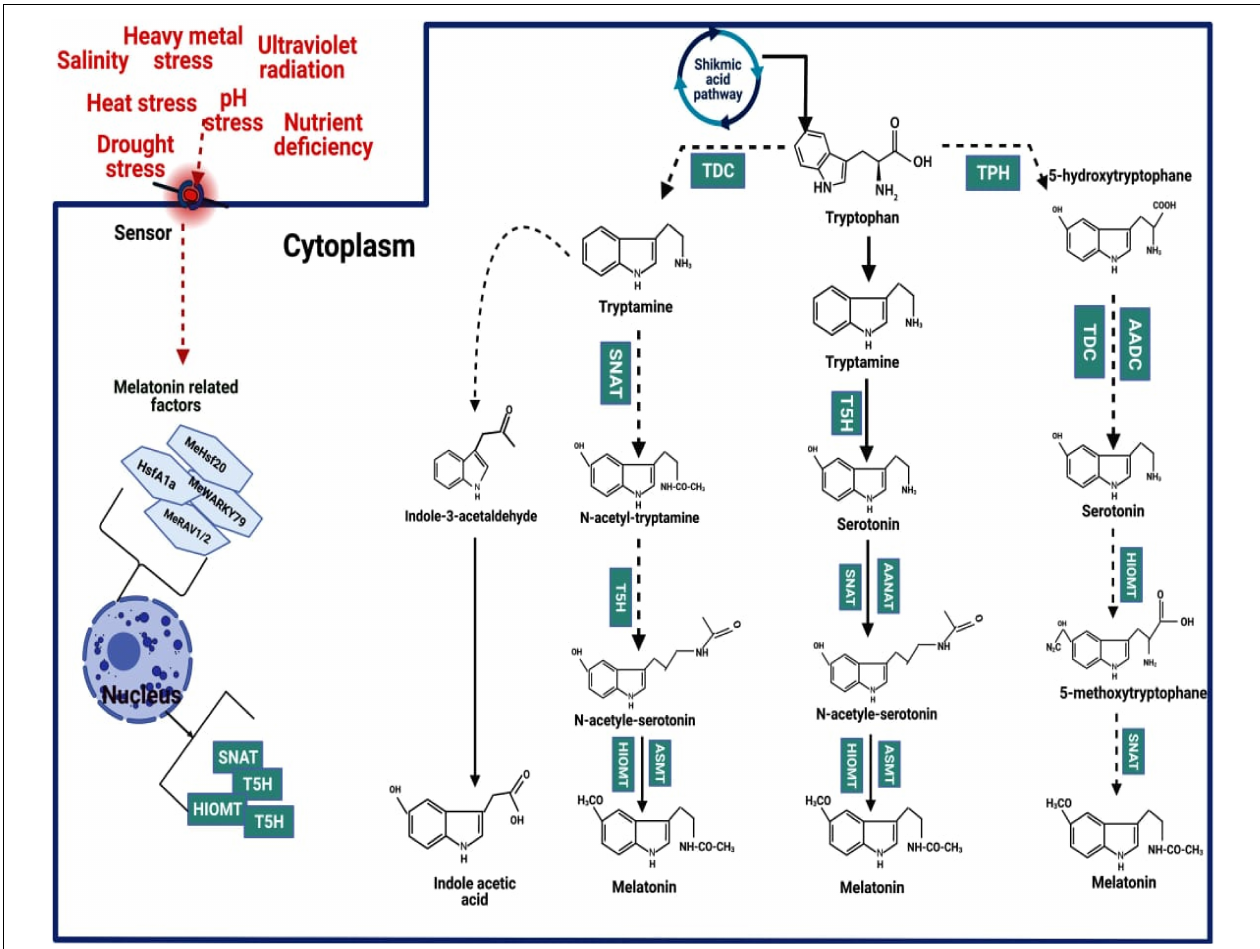
FIGURE 1 | Mechanism of melatonin biosynthesis in the